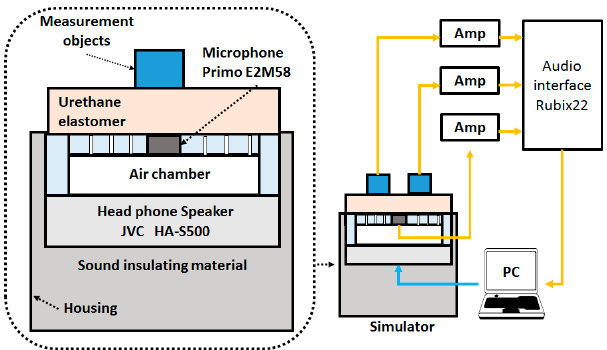
Figure 4. Respiratory sound simulator.